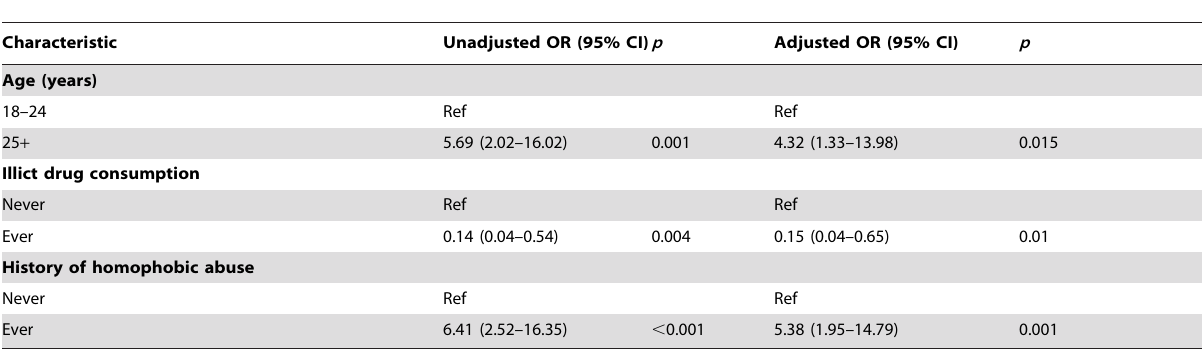
Table 3. Factors associated with HIV seropositivity among MSM (multivariate weighted analysis).